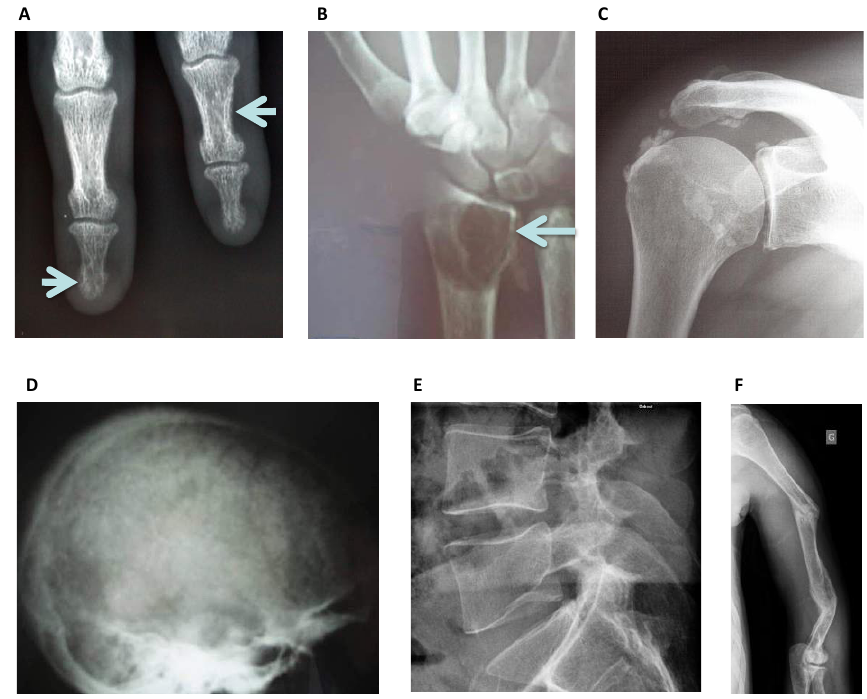
Figure 3. STANDARD SKELETAL X-RAYS IMAGES